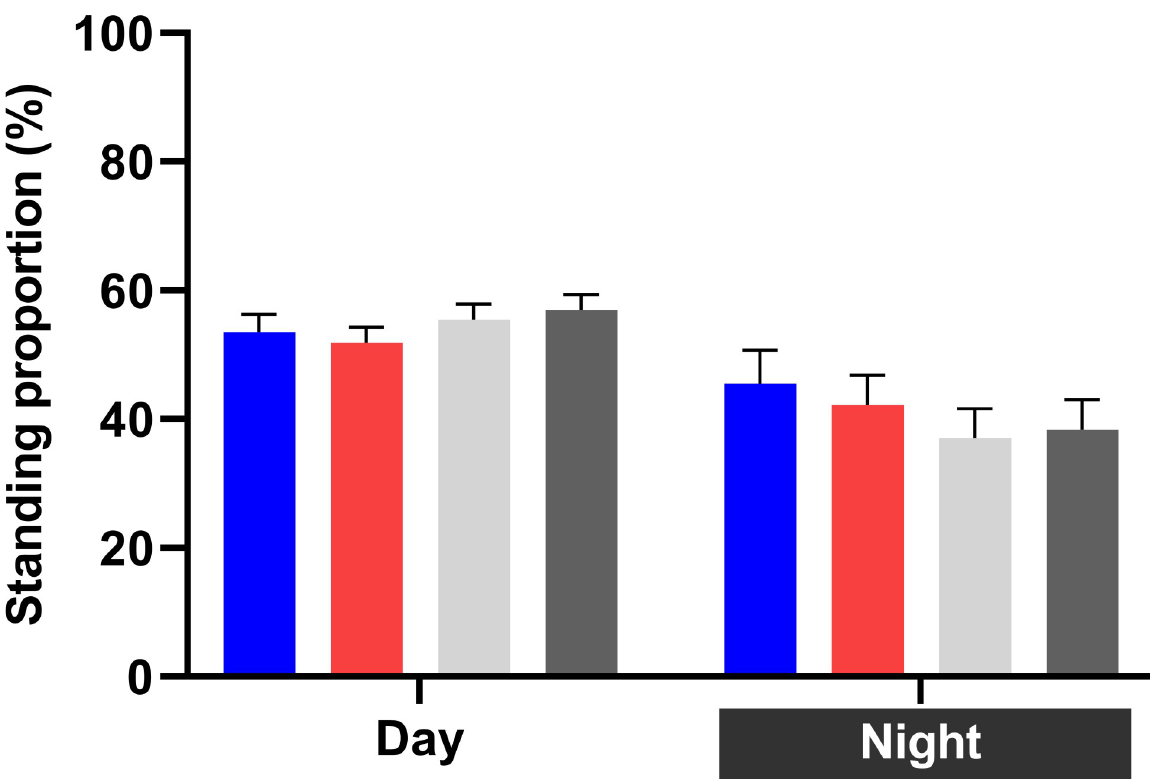
Fig 7. Treatment least squares means (LSM) for activity. Standing proportion per treatmeant, and in daytime (16 h) and night-time (8 h).